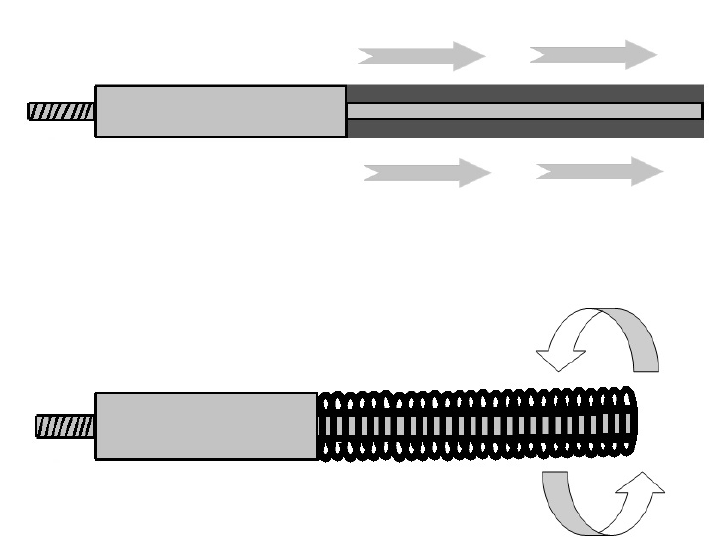
Figure 2. Radiation elements of the dipole antenna, with longitudinal laying on the dielectric insert (top panel) and circular winding on the dielectric insert (bottom